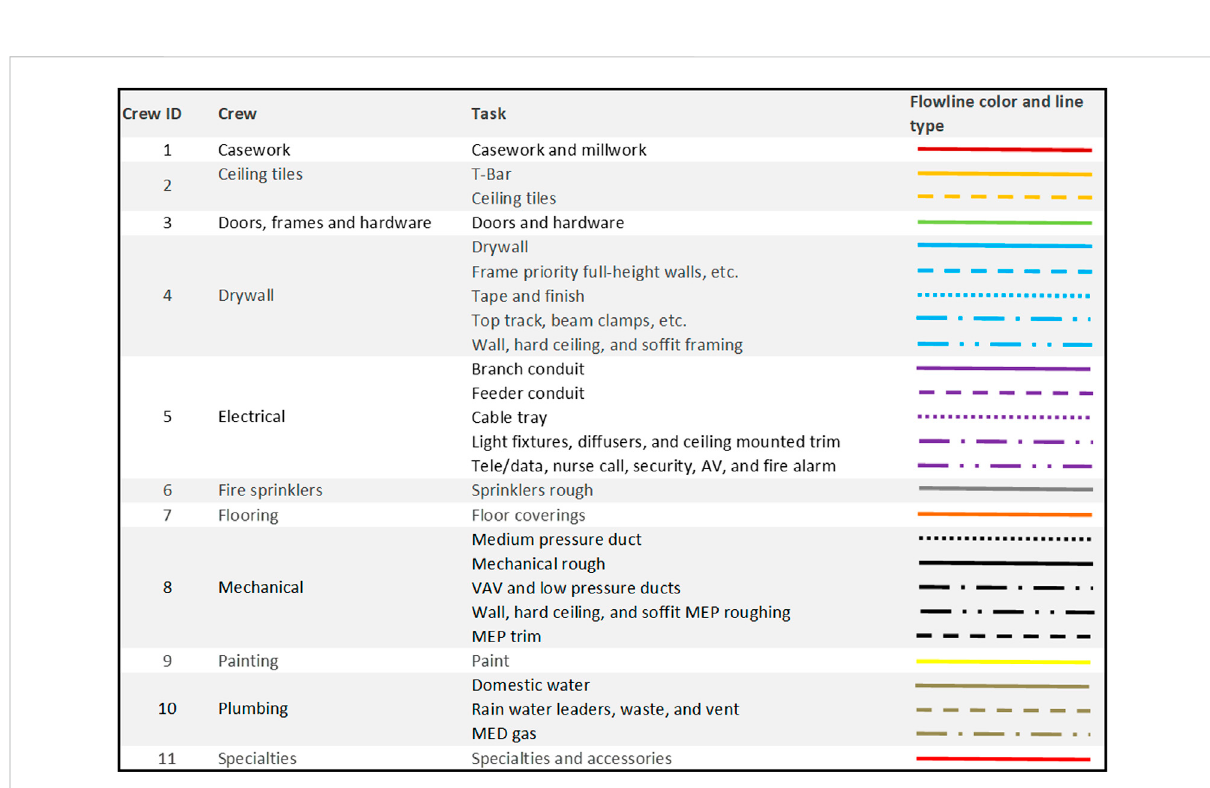
FIGURE 8 Legend for fl owline graphs in this